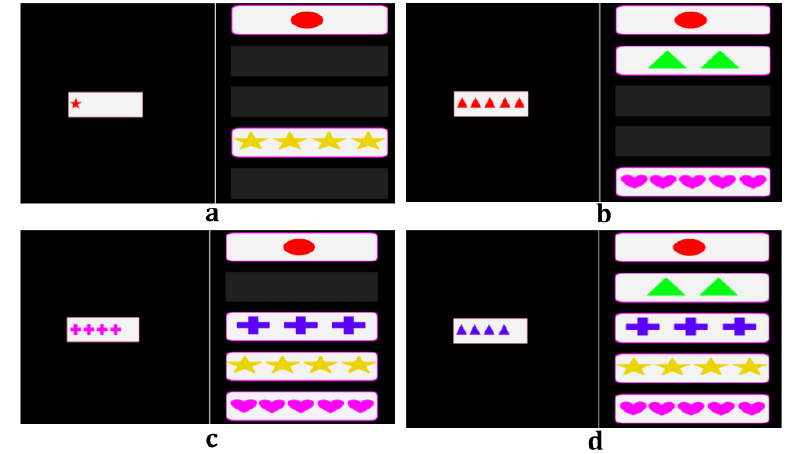
Figure 2. Our implementation of WCST. During a complete game, the user must play all the different cases (i.e., a – d ). In V1 the game starts with two possible choices ( a ) and the choices increase gradually by one until a total number of 5 choices ( d ) has been reached. In V2 options a, b, c, and d are changing randomly after every 4 rounds under the same decision rule. At the end of V1 and V2 each user has played around 32 rounds of each a, b, c, and d